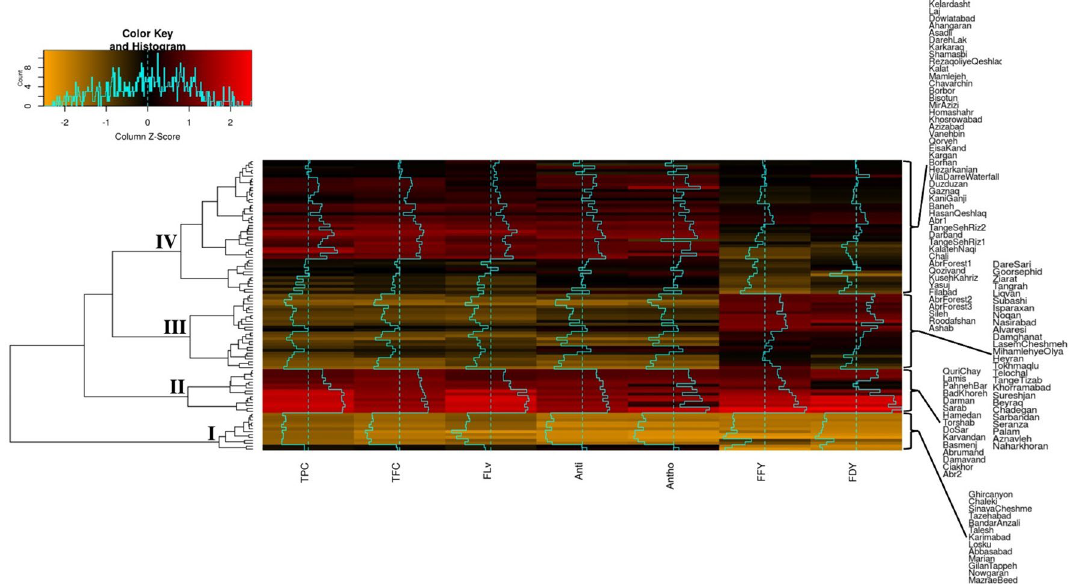
Figure 5. Heat-map and two-dimensional dendrogram for 100 Poa pratensis accessions tested for polyphenols content, antioxidant activity and forage yield traits in non-stress treatment. Dendrogram illustrates the relation between accessions (rows) and traits (columns) based on variations in color shades obtained using Z-score. TPC, TFC, FLv, Anti, Antho, FFY and FDY represent vectors of total phenol content, total flavonoid content, flavanone, antioxidant activity, anthocyanin, fresh forage yield and dry forage yield,